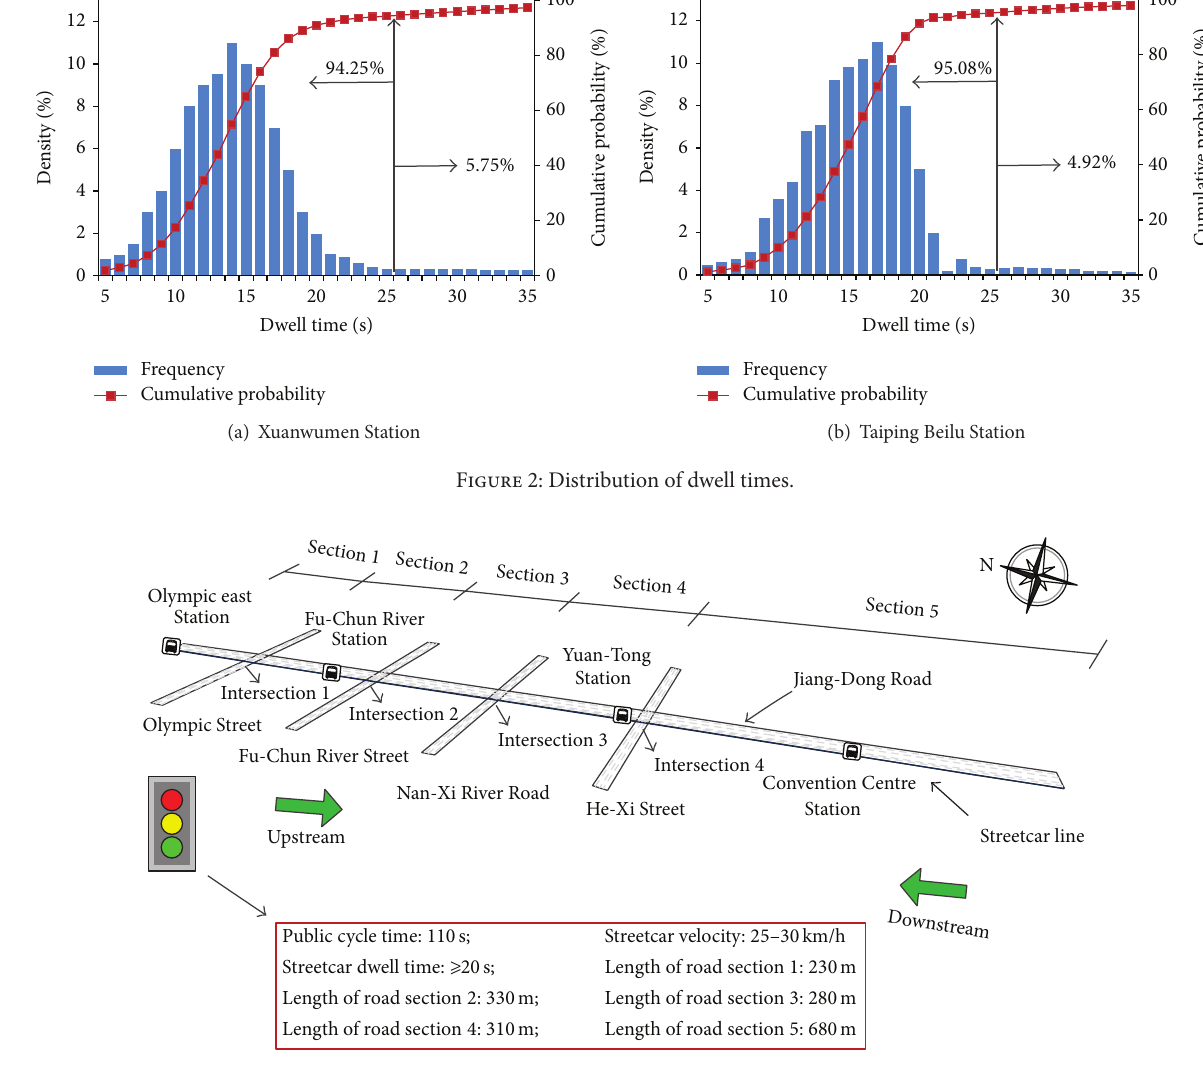
Figure 3: Basic layouts of the